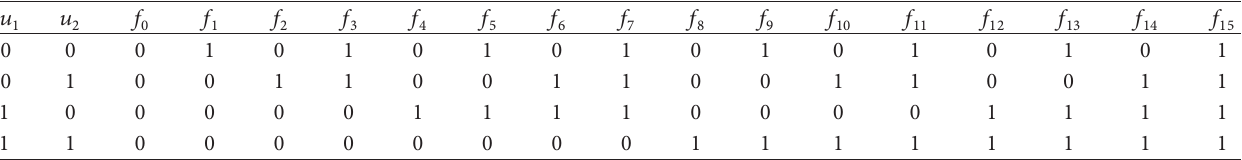
Table 3: Logic functions.